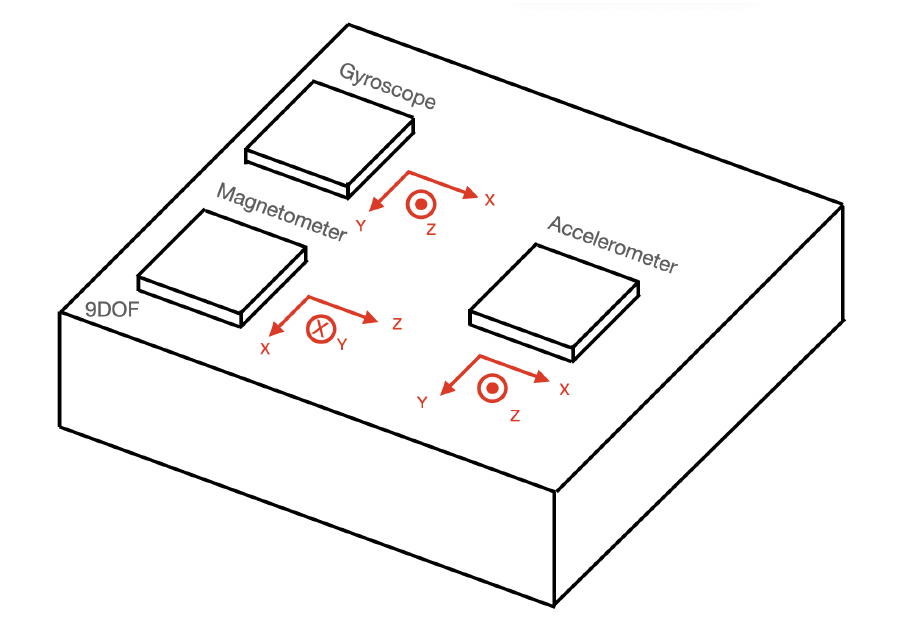
Figure 6. Inertial Measurement